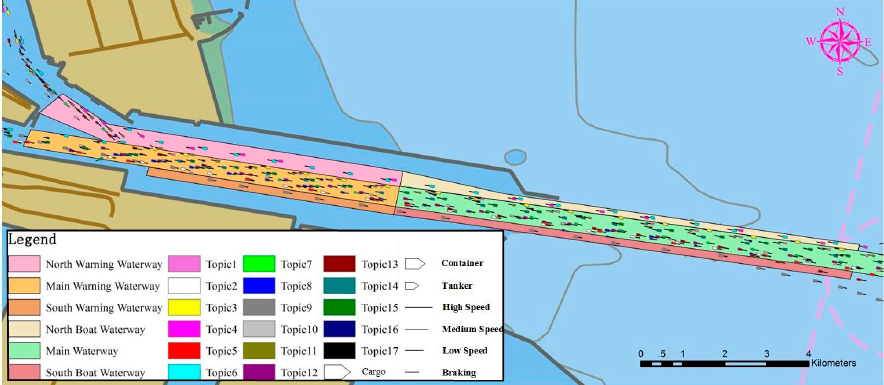
Figure 12. Visualization of the spatial distribution of 17 motion pattern topics entering and leaving the Tianjin port waterway.